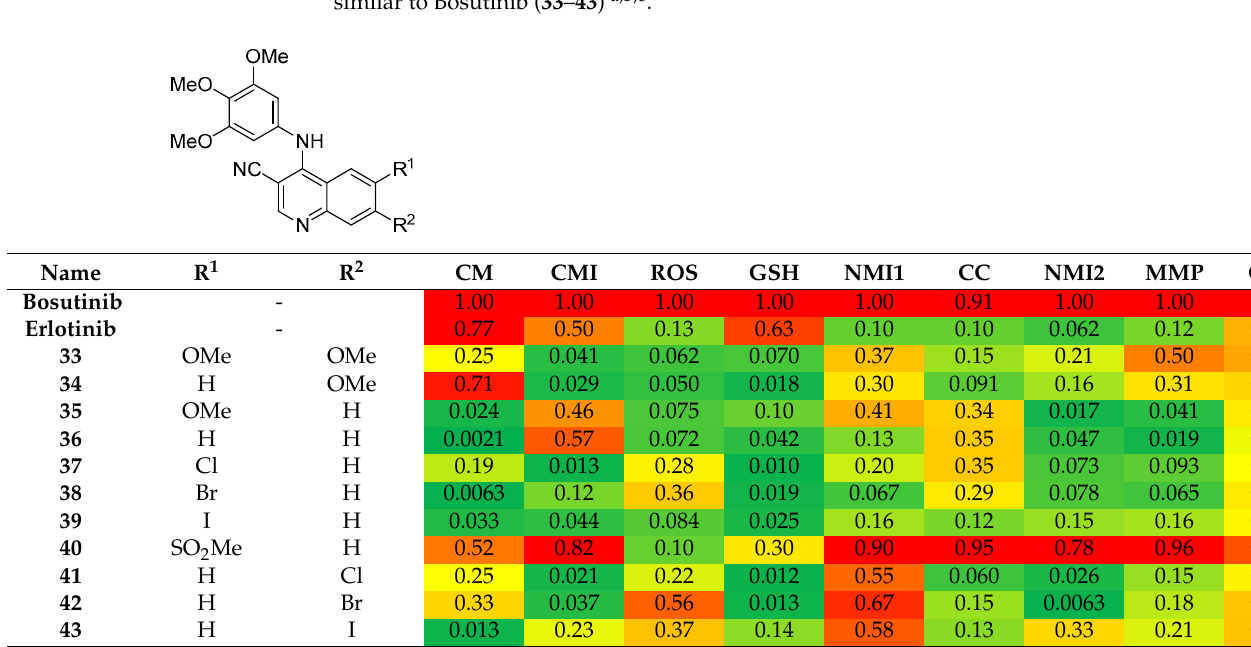
Table 4. Toxicity profiling of 3,4,5-trimethoxyaniline analogs containing a 3-cyanoquinoline scaffold similar to Bosutinib ( 33 – 43 ) a,b,c .